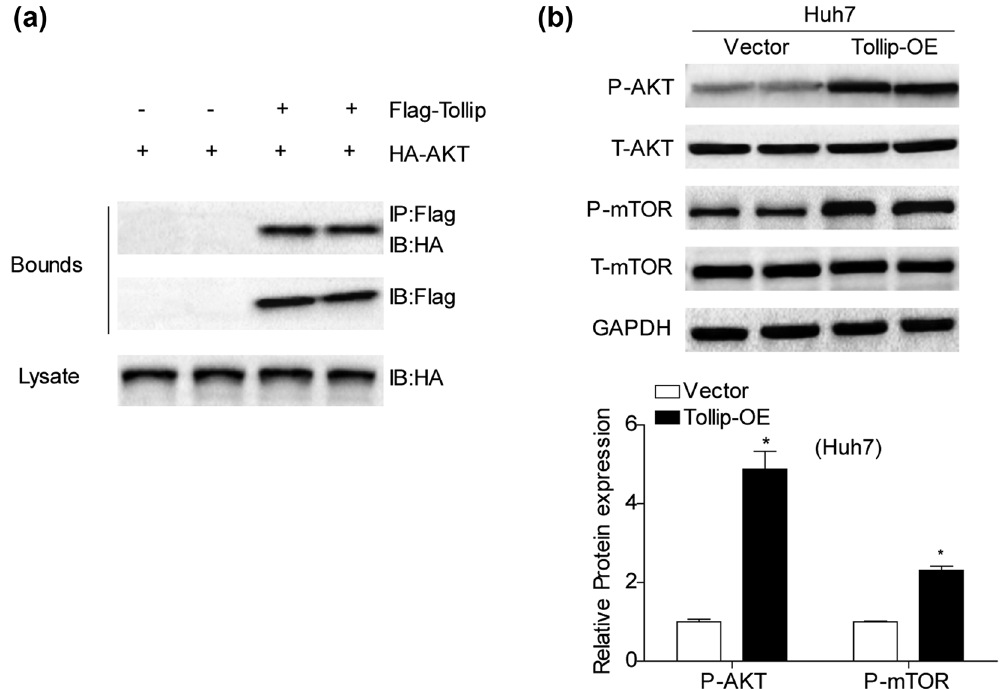
Figure 4: The regulation of PI3K/AKT signaling pathway in HCC cells by Tollip. ( a ) Western blots were performed with Tollip or AKT antibody after co - IP of Tollip. ( b ) Immunoblot showed AKT and mTOR phosphorylation and total levels in Tollip - OE and vector group. n = 3 independent experiments. * p < 0.05 compared with control group.